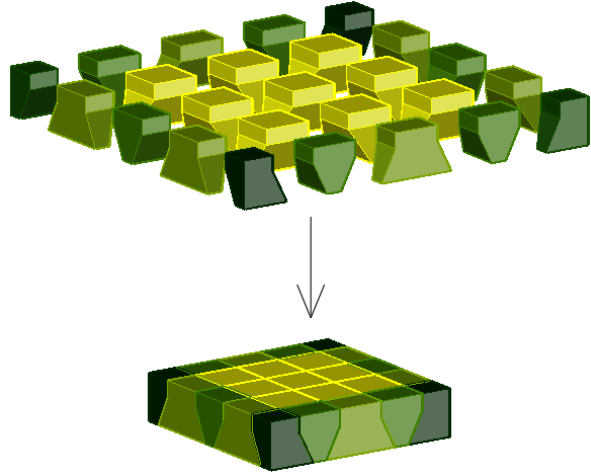
Figure 21. One-sided smooth vault from components enlarged by a layer of constant thickness.